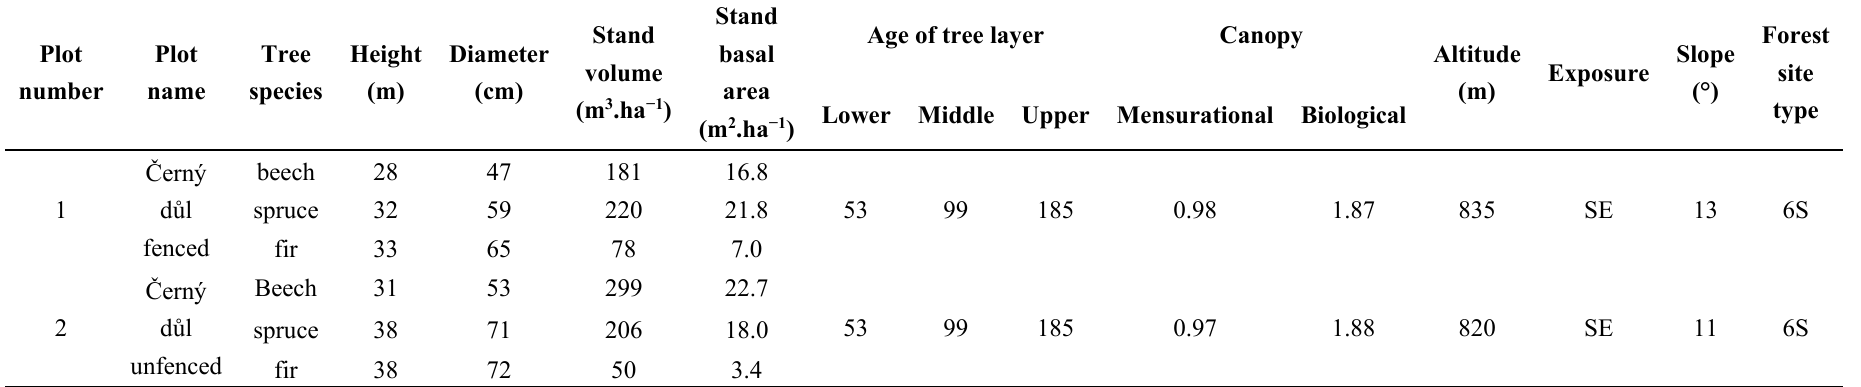
Table 1. Present characteristics of PRP 1 and PRP